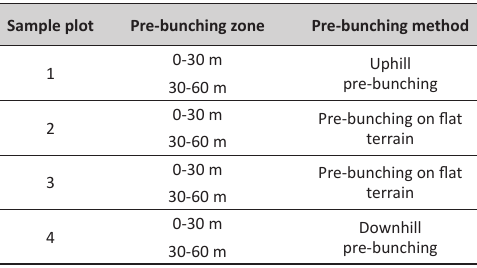
TAbLe 1. Pre-bunching method at the sample plot.